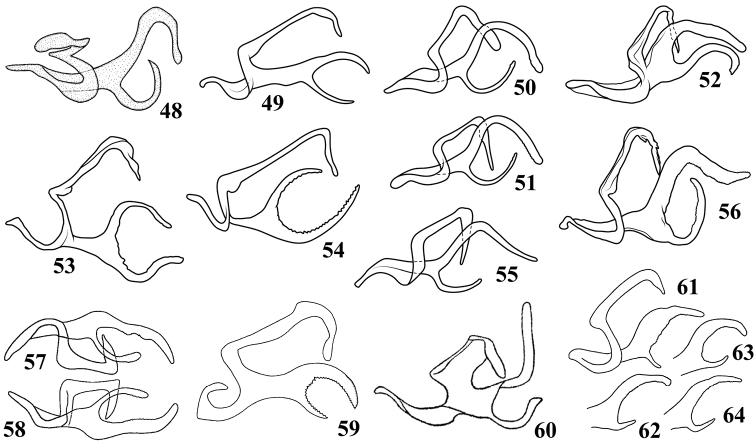
Dorsal connectives of Oncopsis in Sichuan, lateral views 48O.anchorous (after Xu et al. 2006) 49O.furca50–51O.fusca (after Lauterer and Anufriev 1969) 52O.graciaedeagus53O.hailuogouensis54O.kangdingensis55O.kuluensis56O.ludingensis57–58O.melichari (after Lauterer and Anufriev 1969) 59O.nigrofasciata (after Xu et al. 2006) 60O.trimaculata (after Kuoh 1992) 61–64O.tristis (after Tishechkin 2017).